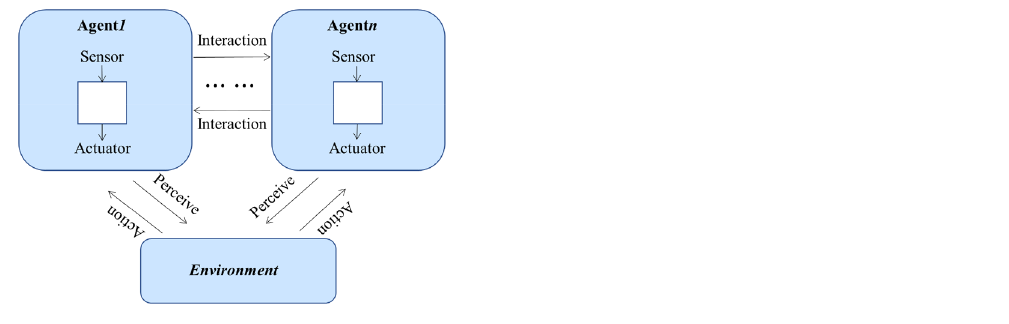
Figure 5. Attributes of an